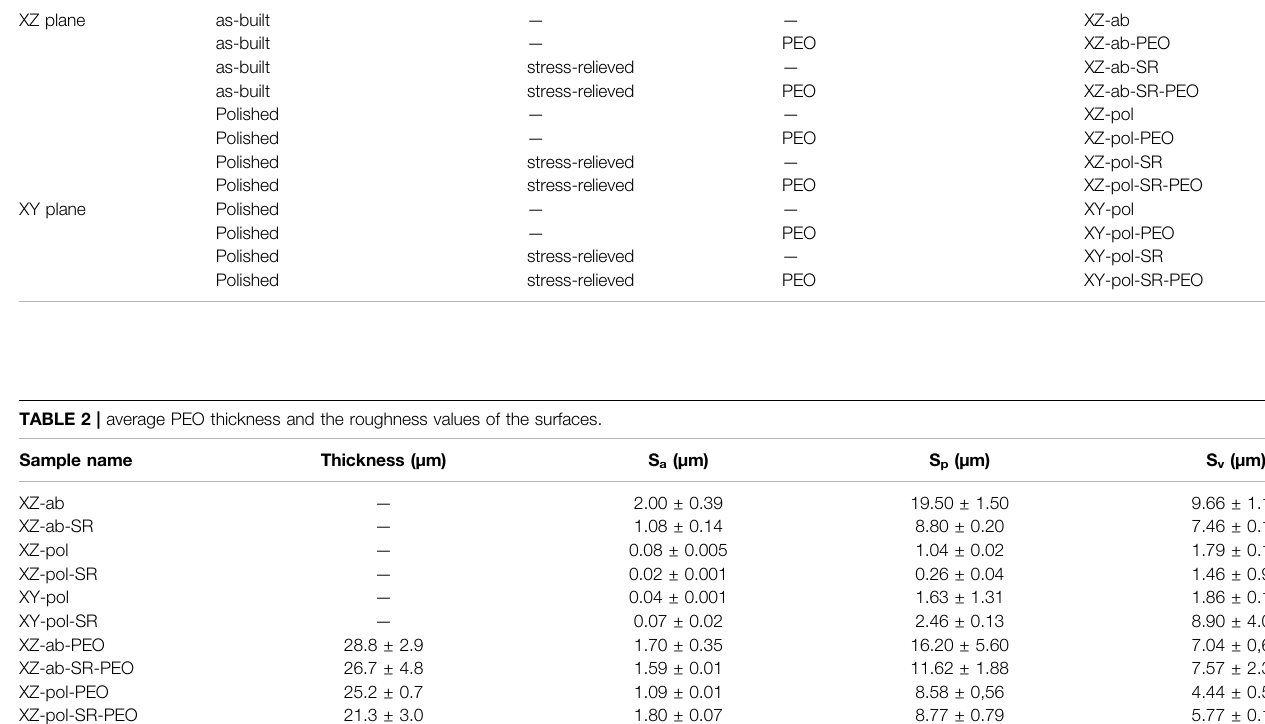
TABLE 1 | List of surface treatments used in this study. Plane